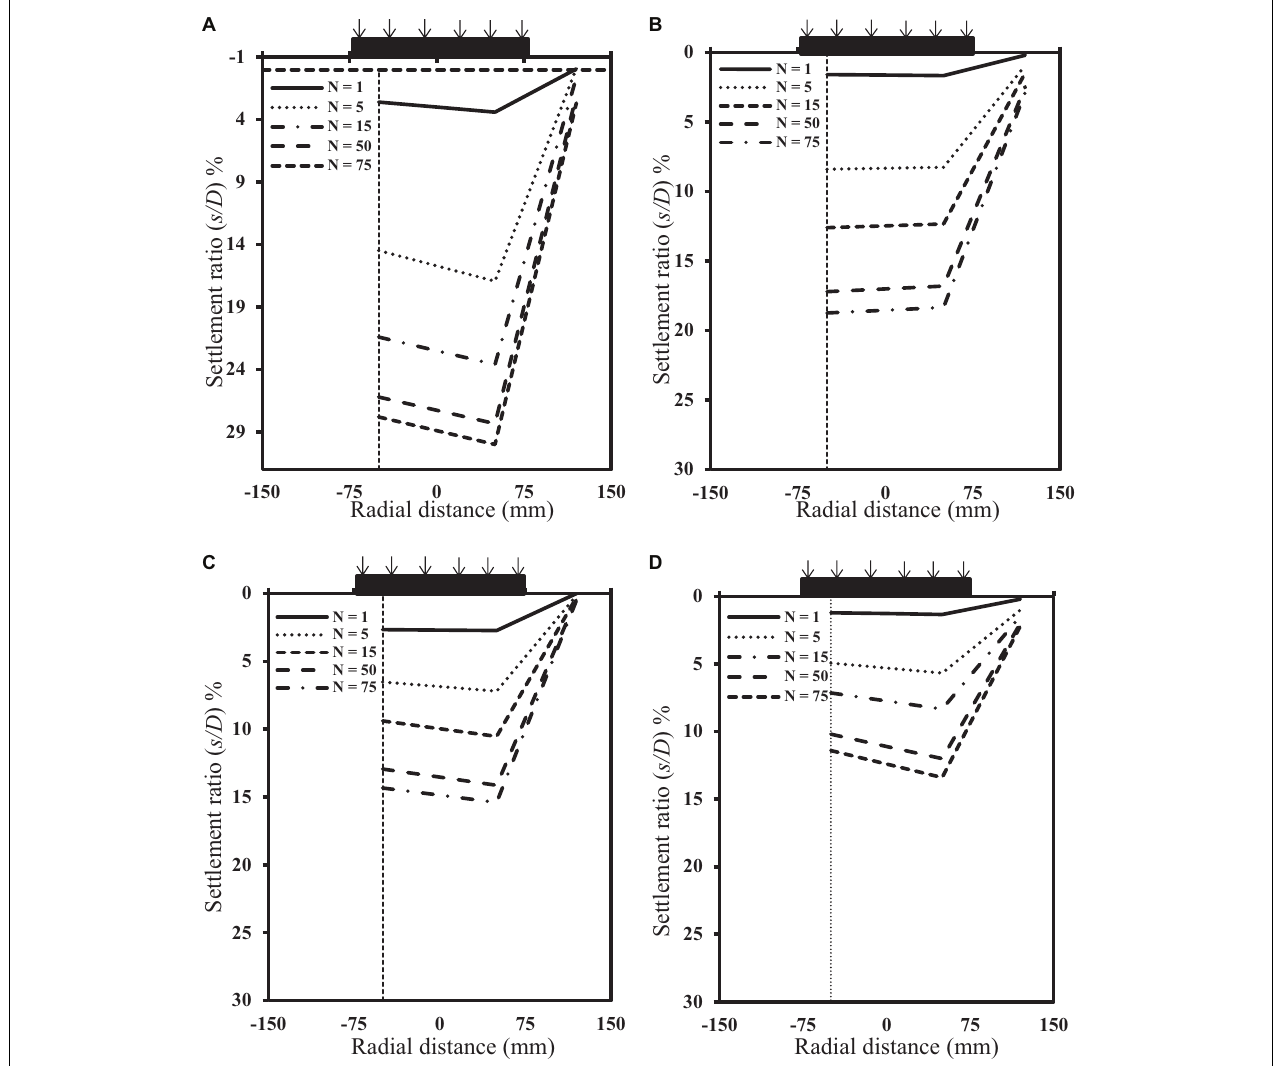
FIGURE 7 | Settlement contours: (A) unreinforced subgrade; (B) geogrid reinforced subgrade; (C) geocell reinforced subgrade; (D) geocell with a basal geogrid reinforced